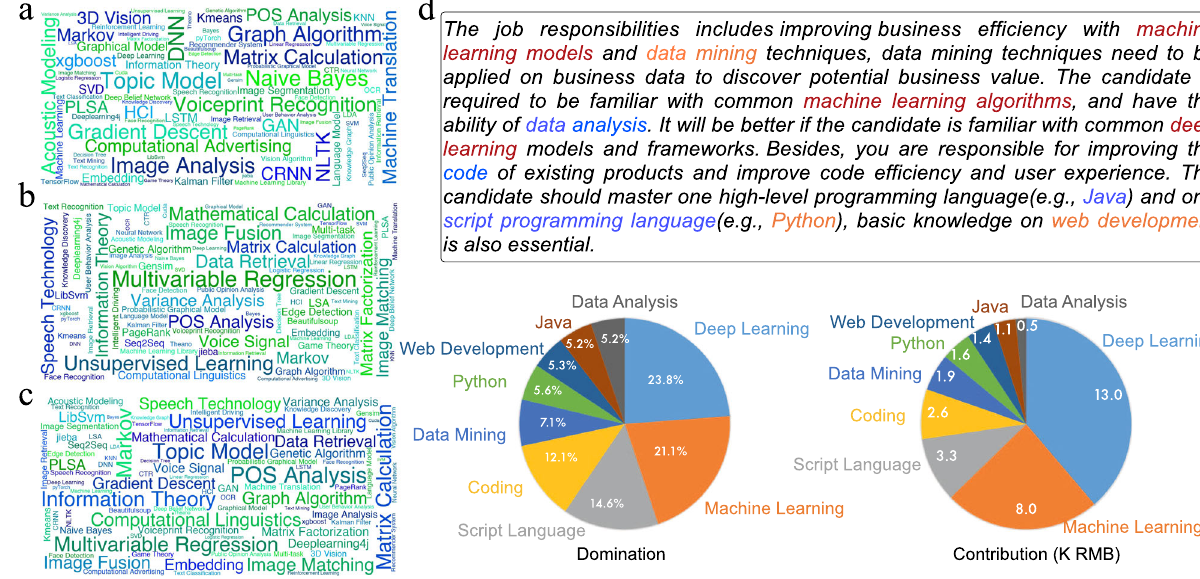
Fig. 4 Visualizations of skill salary decompositions. a We calculated the averaged context-aware skill value estimated by CSVN and drew word cloud of machine learning-related skills, where the size of each word shows the skill value. b Similar to the word cloud of skill value, we drew word cloud for averaged skill domination estimated by ASDN. c For each skill in a job posting, we can calculate the actual salary contribution of it by calculating the multiplication of its value and domination, and show the averaged contribution of each skill on the word cloud. d A case study on a job posting, the role of each skill is analyzed by calculating their domination, contribution, and in fl uence on job salary. The color of words in the job description shows the skills' in fl uence on salary, blue/yellow/red means the salary will increase/remain/decrease by dropping the skill. The pie plots show skill domination and contribution where the colors distinguish different skills.